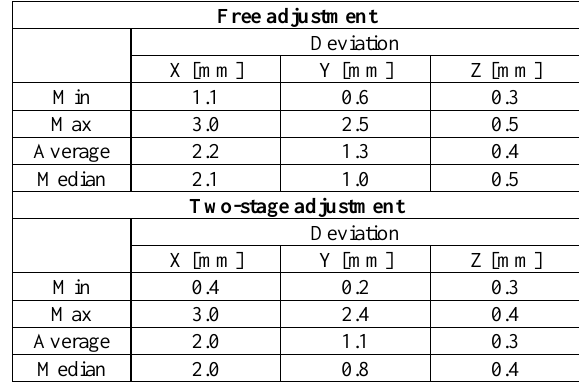
Table 1. The statistical analysis of the result of the free and two-stage